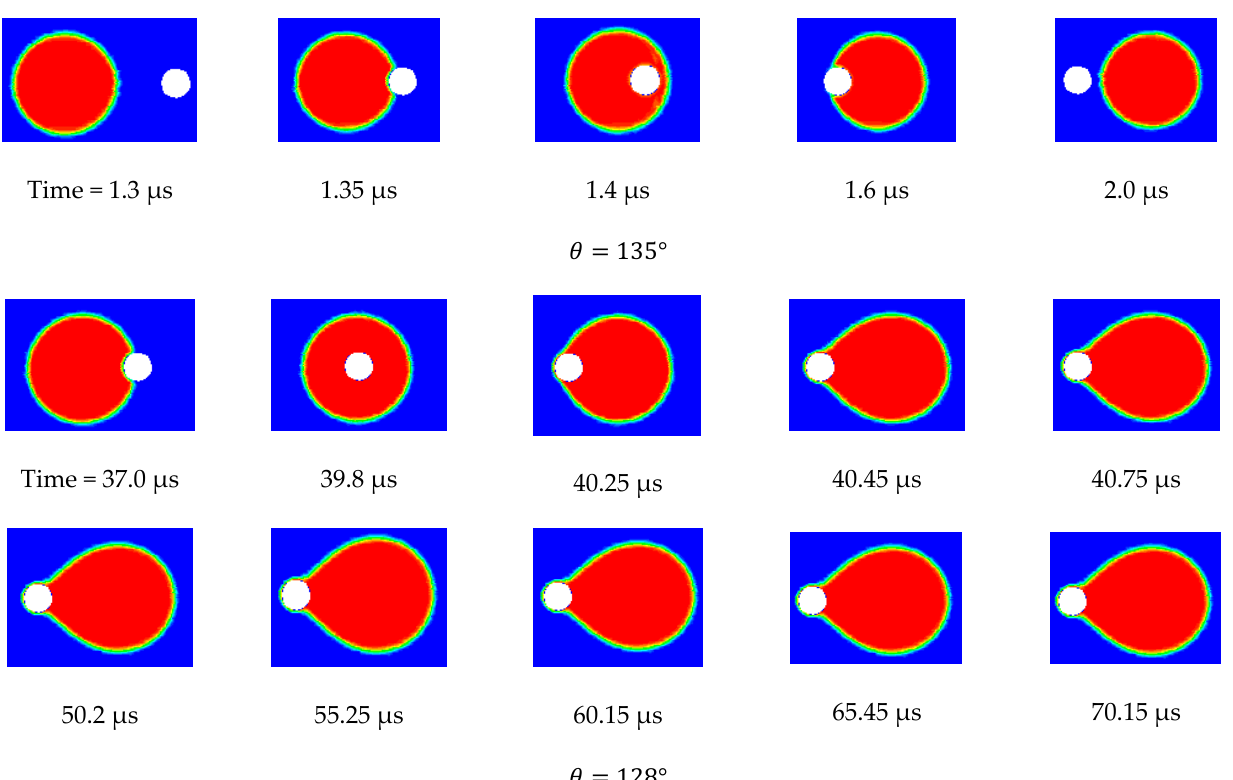
Figure 13. Top view snapshots of the droplet showing that when the contact angle was large and no permeation occurred, the droplet encountered the pore opening and passed through it. The shape of the contact line, in this case, was almost circular. When the contact angle was reduced and pinning conditions occurred, the droplet became held and was no longer able to move. It is also clear that the contact area was larger for smaller contact angles.